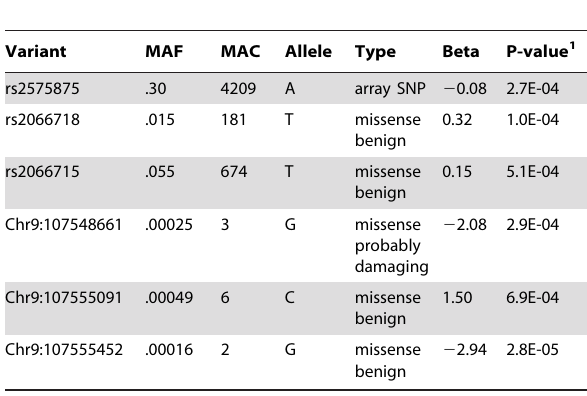
Table 3. Rare and common variants contribute to the association signal to HDL-C in gene ABCA1